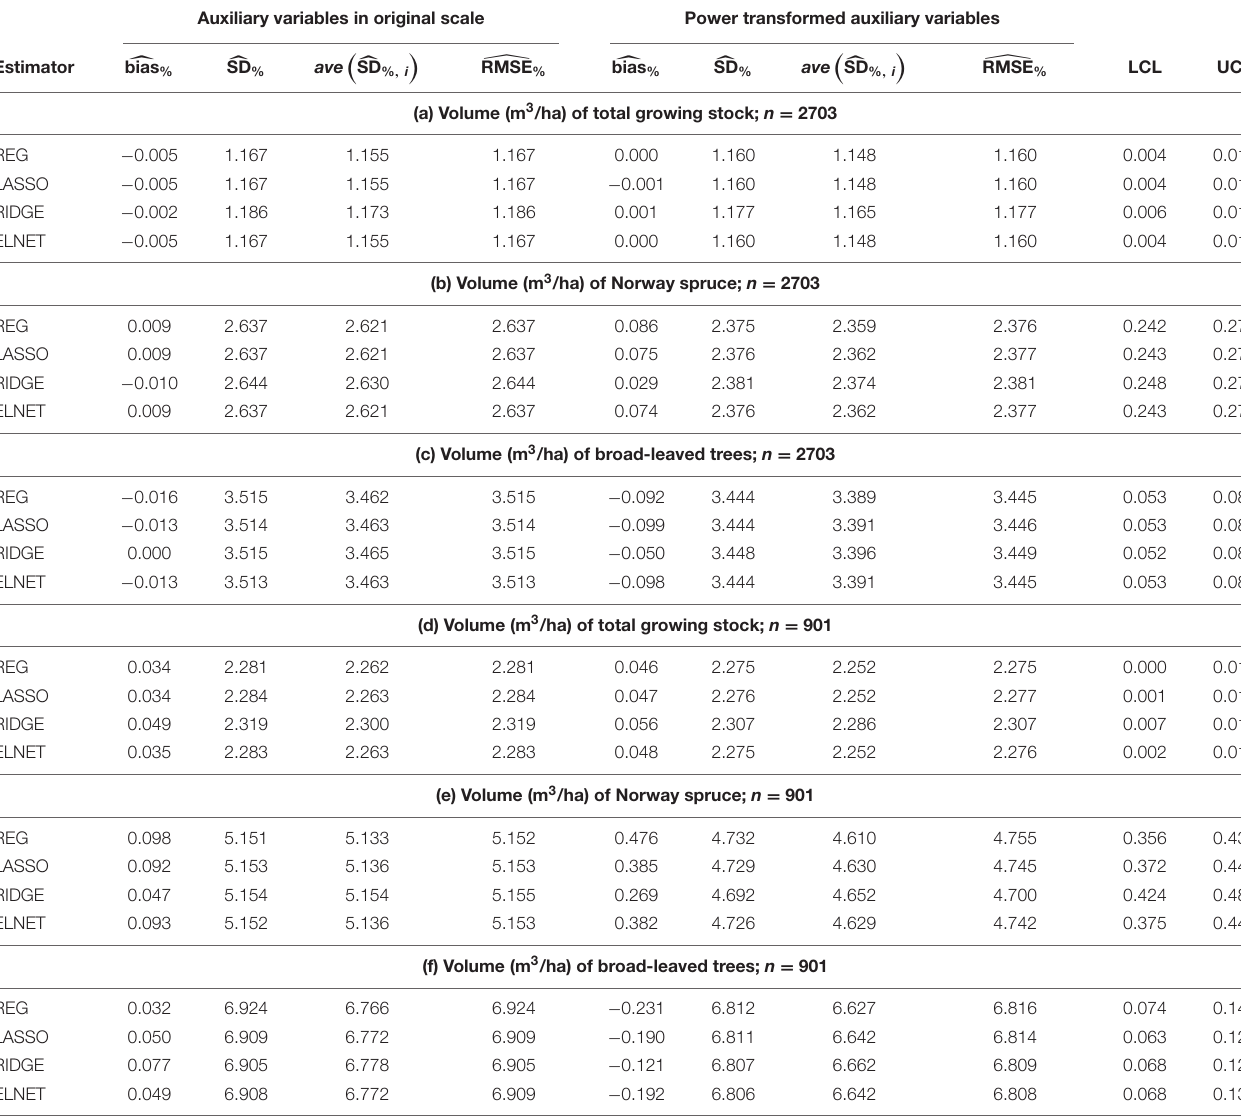
TABLE 5 | Monte Carlo results for REG, LASSO, RIDGE, and ELNET, when based on an expert selection of auxiliary variables. Auxiliary variables in original scale Power transformed auxiliary